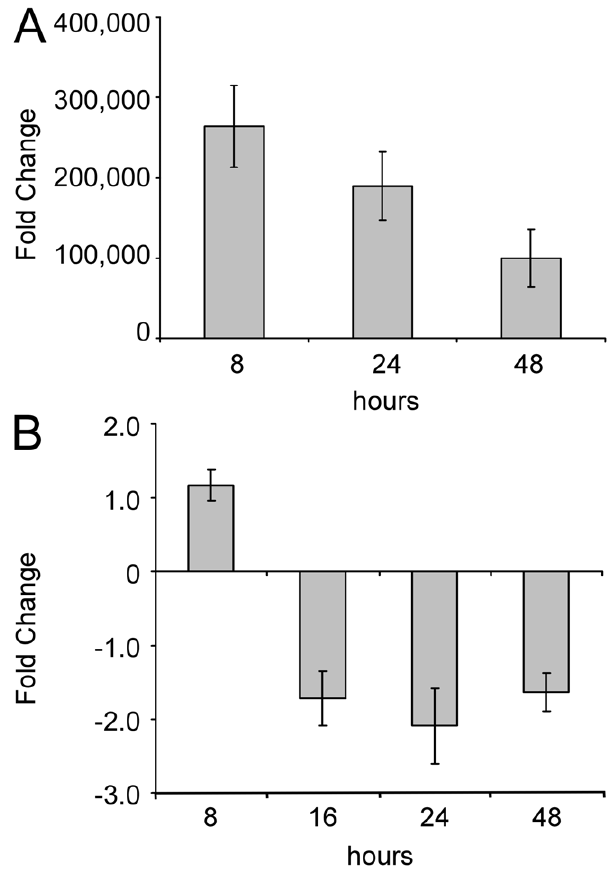
Figure 4. Altering the expression of miR-146a in microglia. A. MiR-146a over-expression as measured by TaqMan H qRT-PCR in microglia cells after 8, 24, and 48 hrs of treatment with 30 nM (previously optimized, data not shown) of transfected pre-miR-146a in comparison to 30 nM of transfected scrambled negative control miRNA. An average fold change and standard deviation were measured from triplicate experiments. B. MiR-146a knock-down as measured by TaqMan H qRT-PCR in microglia cells after 8, 24, and 48 hrs of treatment with 50 nM (previously optimized, data not shown) of transfected anti- miR-146a in comparison to 50 nM of transfected scrambled negative control miRNA. An average fold change and standard deviation were measured from triplicate